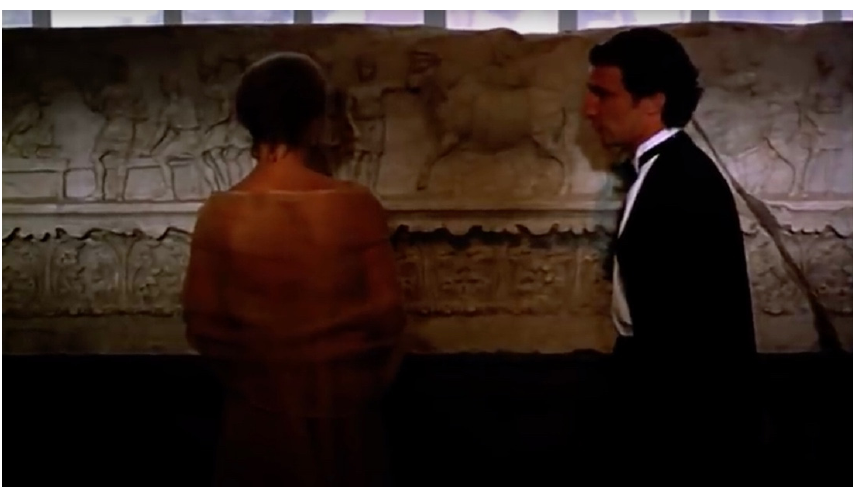
Figure 8. Scene from Le fate ignoranti ( His Secret Life , 2001) directed by Ferzan Özpetek.